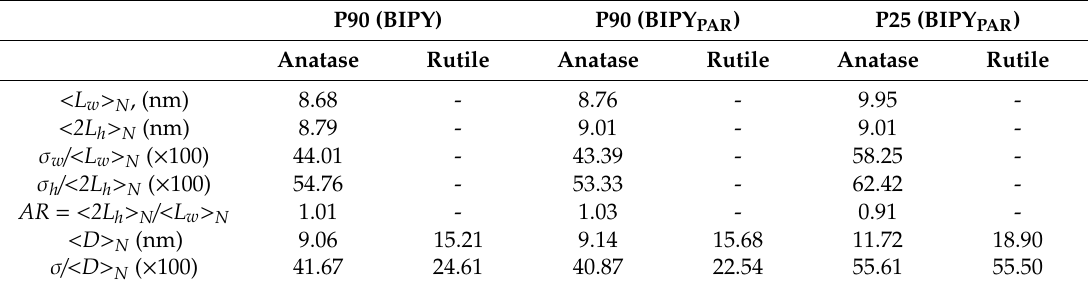
Table A2. Results from the DSE analysis of P90 and P25 using synchrotron WAXTS data and the BIPY and / or BIPY PAR models for anatase NCs. Averages are all number based. Entries as in Table 2. P90